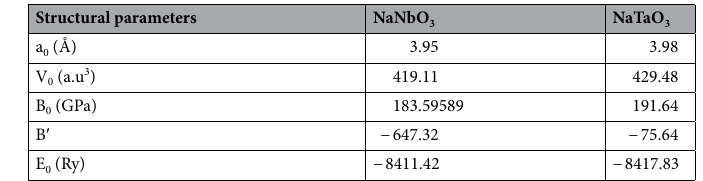
Table 1. The structural parameters, i.e., lattice constant (a 0 ), optimized volume (V 0 ), Bulk modulus (B 0 ), pressure derivative (B ′ ) and ground-state energy (E 0 ), of ternary alkali (Na)-based niobate (NaNbO 3 ) and tantalate (NaTaO 3 ) perovskites, obtained by the Birch–Murnaghan fitting to the energy-volume curves.